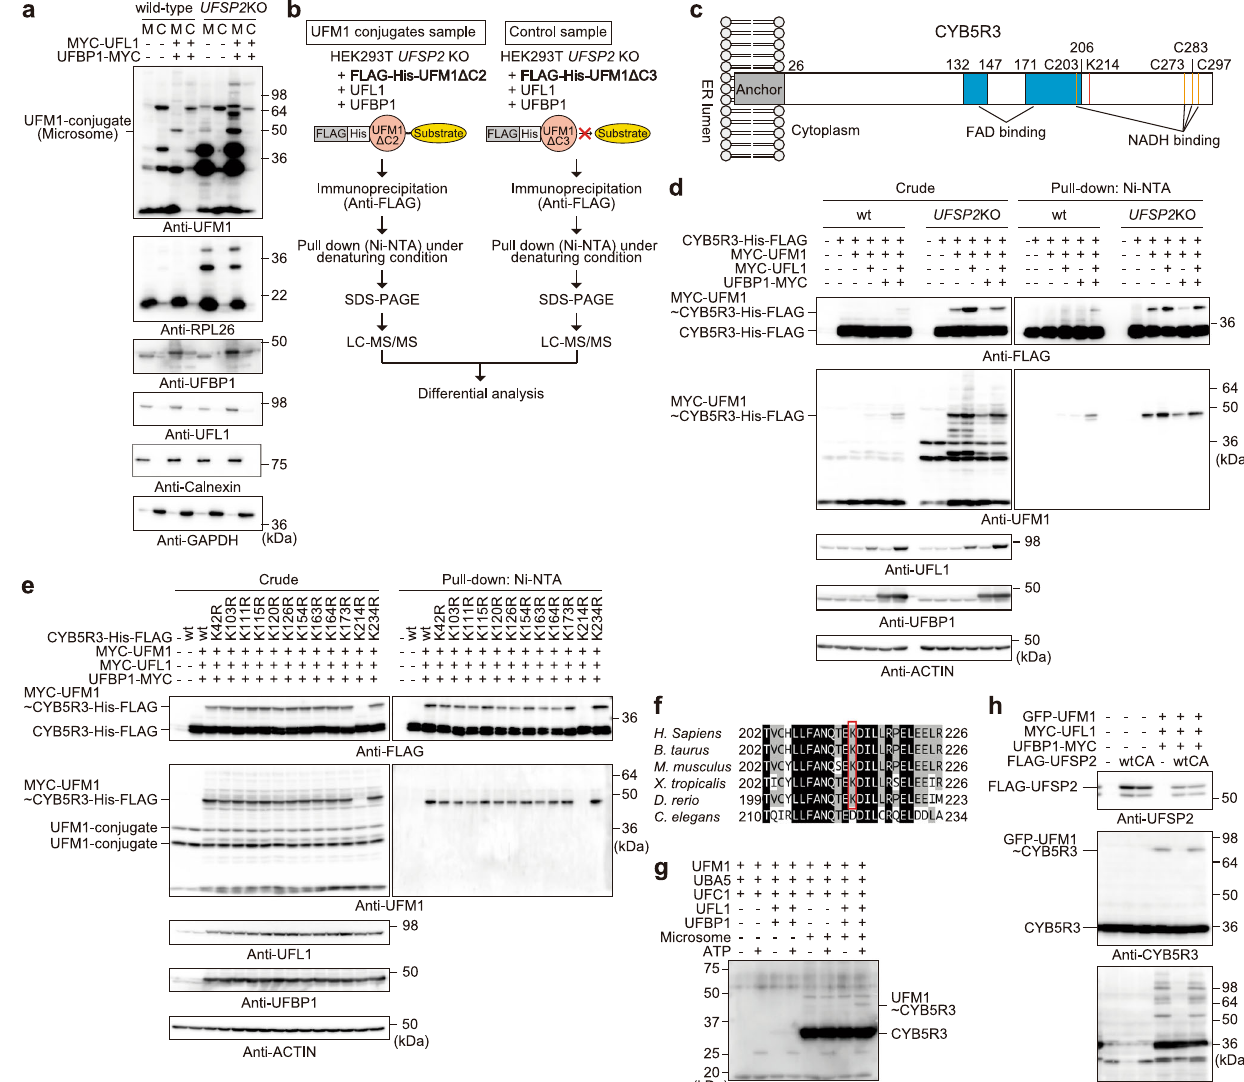
Fig. 1 | CYB5R3 is a bona fi de substratefor UFM1. a Immunoblot analysis. Wild- type or UFSP2 − / − HEK293T expressing UFL1 and UFBP1 were fractionated into microsomal (M) and cytoplasmic (C) fractions followed by immunoblot ana- lysis. Data shown are representative of three separate experiments. b An experimental approach to identify ufmylated proteins. c Domain structure of CYB5R3. Membrane anchor, FAD-binding site, and lysine residue for UFM1 conjugation are indicated. d Immunoblot analysis. The indicated constructs were transfected into parental or UFSP2 − / − HEK293T. 48h after the transfec- tion, the cell lysates were pulled down with Ni-NTA agarose under denaturing conditions followed by immunoblot analysis. Data shown are representative of three separate experiments. e Immunoblot analysis. A series of CYB5R3KR mutants together with MYC-UFM1, MYC-UFL1, and UFBP-MYC were expressed